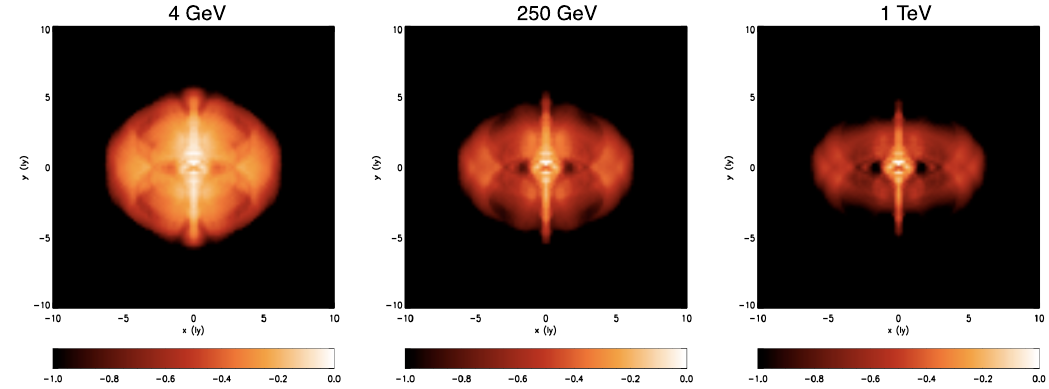
Figure 4. IC surface brightness maps at various energies in the gamma-ray range. Each map is normalized to its maximum and plotted in logarithmic scale. Reprinted from Volpi et al. (2008) © 2008 ESO.